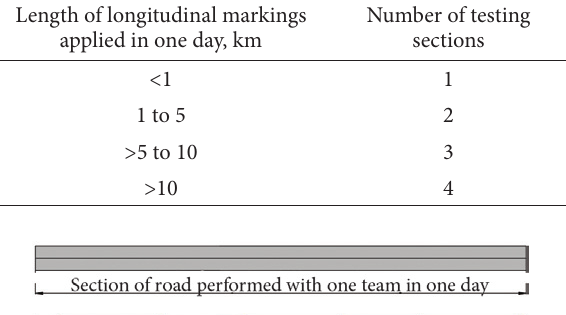
Table 3. Method for determining testing sections according to Hrvatske ceste d.o.o.